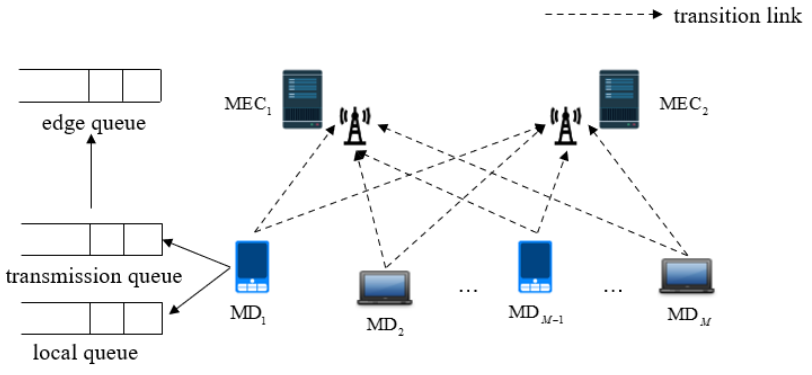
Figure 1. System